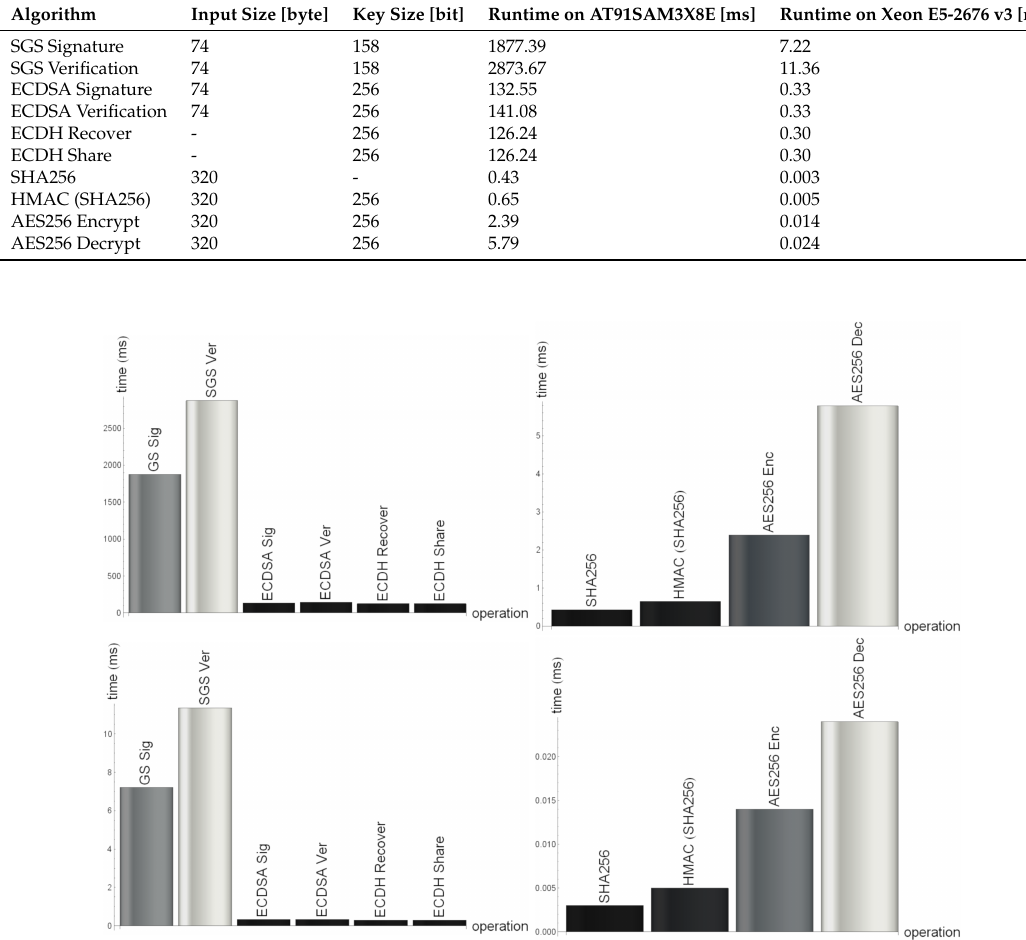
Figure 6. Overview of the computational